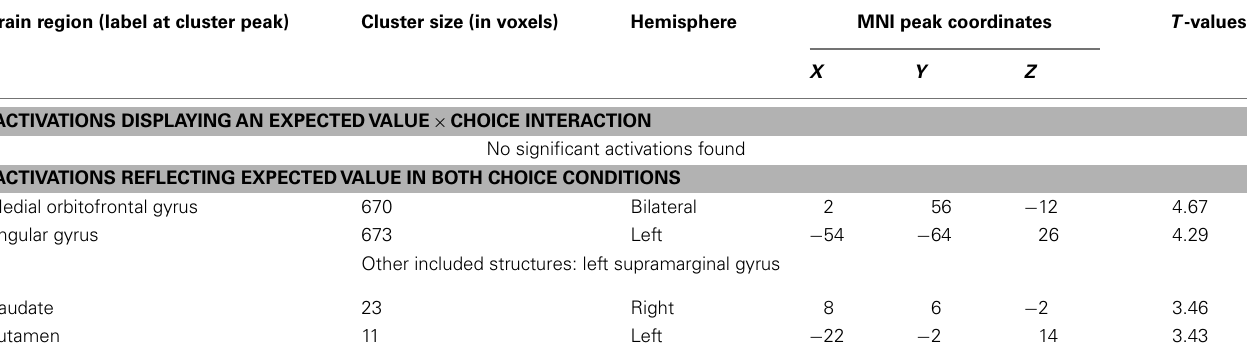
TableA5 | Neural correlates of expected value during selection (GLM3, ROI analysis, P < 0.001, FDR-corrected, k = 10). Brain region (label at cluster